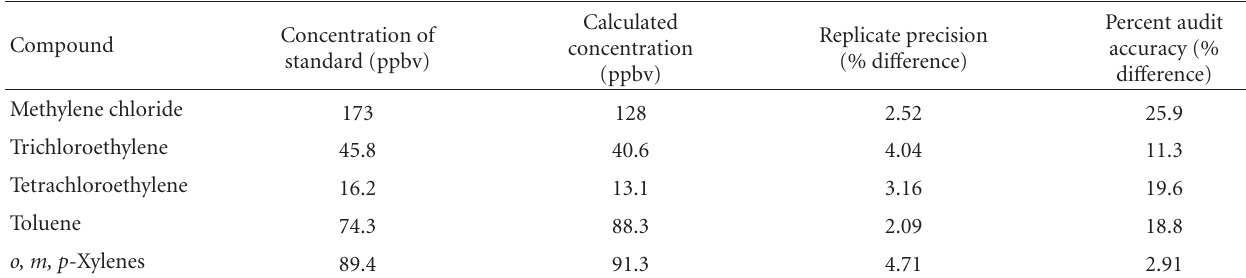
Table 5: Audit accuracy.